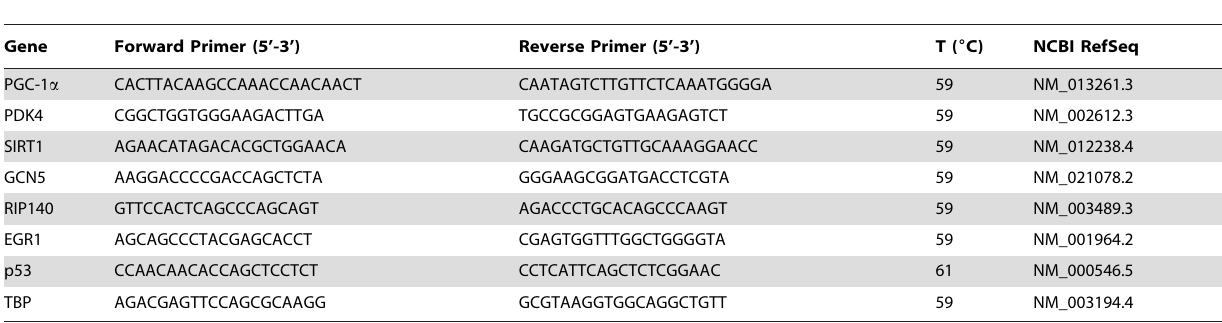
Table 3. List of primer sequences used for real-time PCR and their specific annealing temperatures.